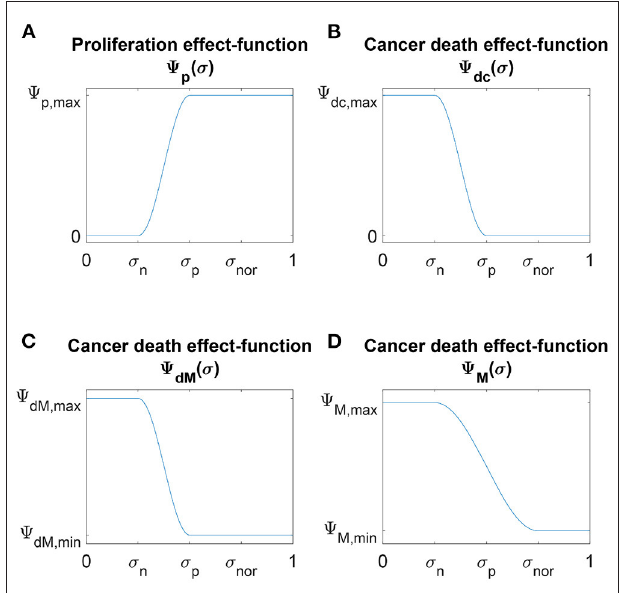
FIGURE 1 | Schematic plots of the four nutrients effect-functions (A) 9 p ( σ ), (B) 9 dc ( σ ), (C) 9 dM ( σ ) and (D) 9 M ( σ ) defined in Equations (4), (6), and (7),